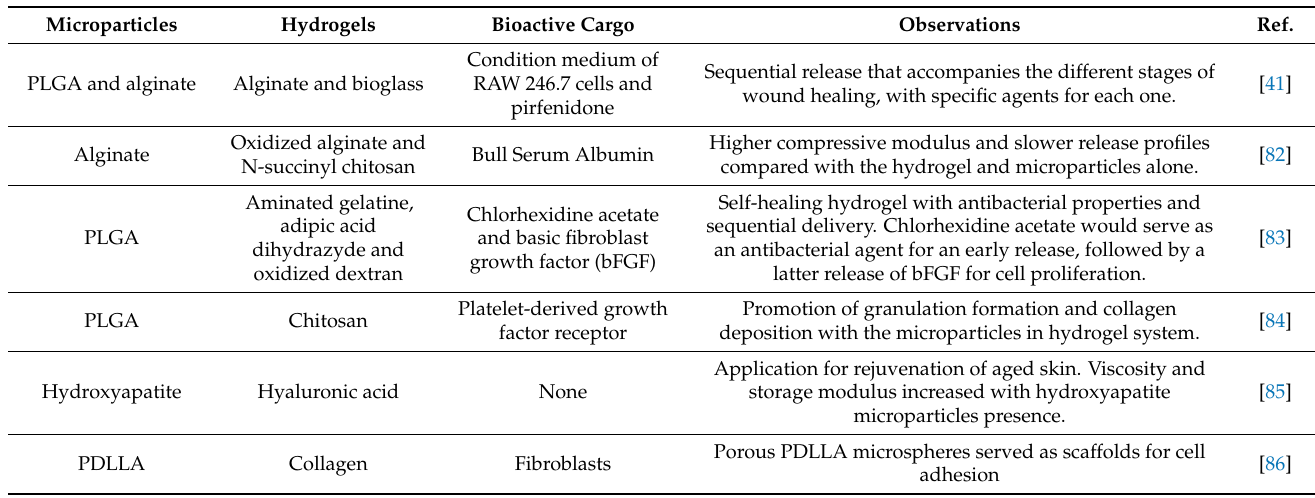
Table 6. Microparticles in hydrogel system for skin treatment.